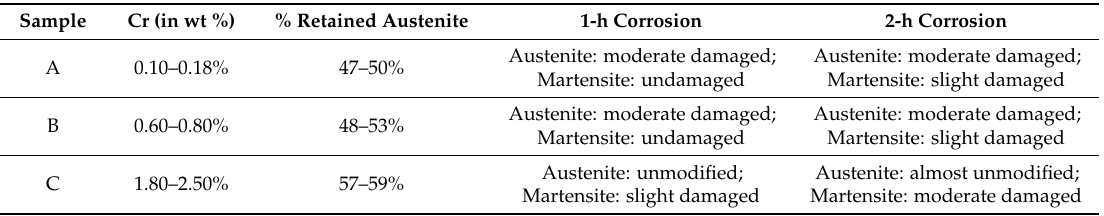
Table 2. Microstructural evolution after the corrosion process for 2-h immersion in 0.1 M